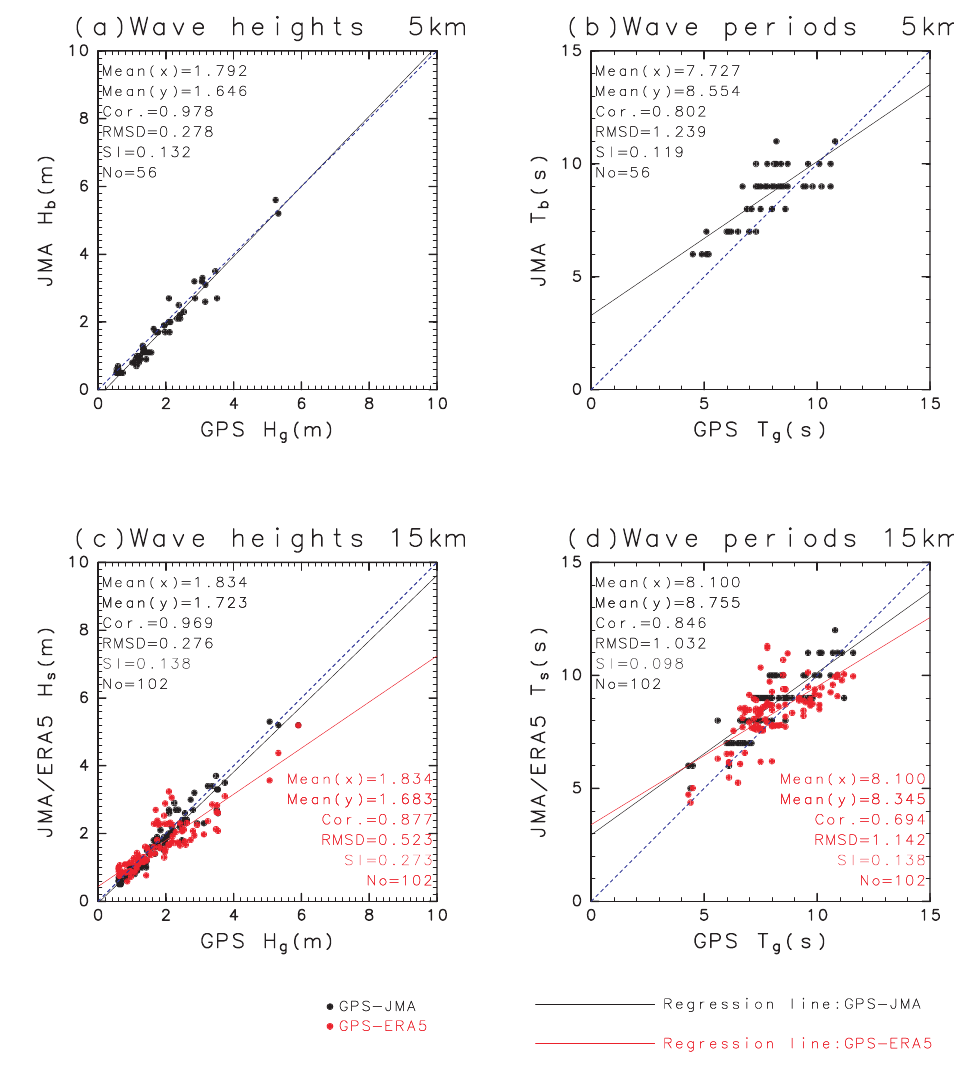
Figure 2. ( a ) Scatter plot and error statistics of the moored GPS buoy-observed wave heights ( H g ) versus the drifting buoy-observed wave heights ( H b ), when the distances between the moored GPS and drifting buoys are less than R dmax = 5 km. The solid line indicates linear regression. The blue dotted line indicates identity line. ( b ) Same as ( a ), but of the moored GPS buoy-observed wave periods ( T g ) versus the drifting buoy-observed wave periods ( T b ). ( c ) Black: Same as ( a ), but when the distances of buoys are less than R dmax = 15 km. Red: same as black, but versus the ERA5 wave heights. ( d ) Same as ( c ), but for the wave